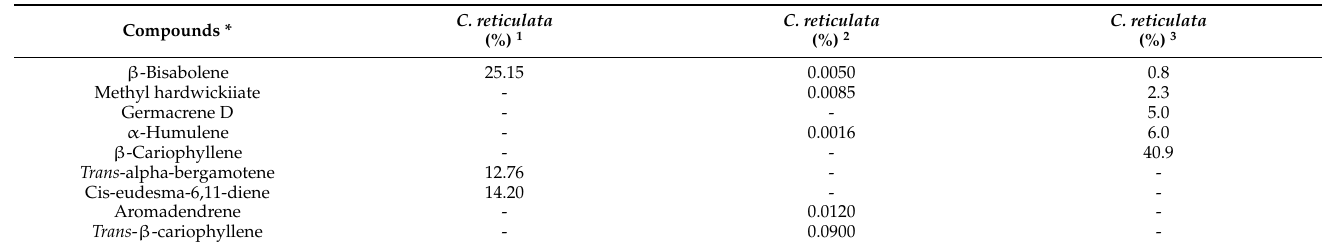
Table 2. Bibliographic references compared to our results.